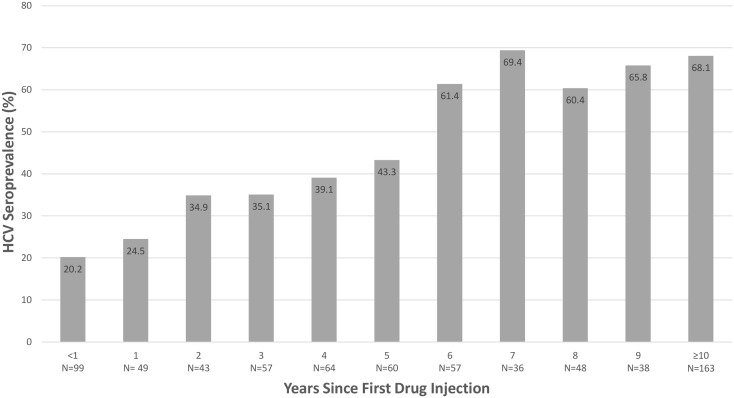
HCV seroprevalence by duration of injection drug use, New York City, 2005–2012.Seroprevalence didn’t rise after 6–7 years, suggesting that people who didn’t get infected during their early years of injection were much less likely to do so thereafter.